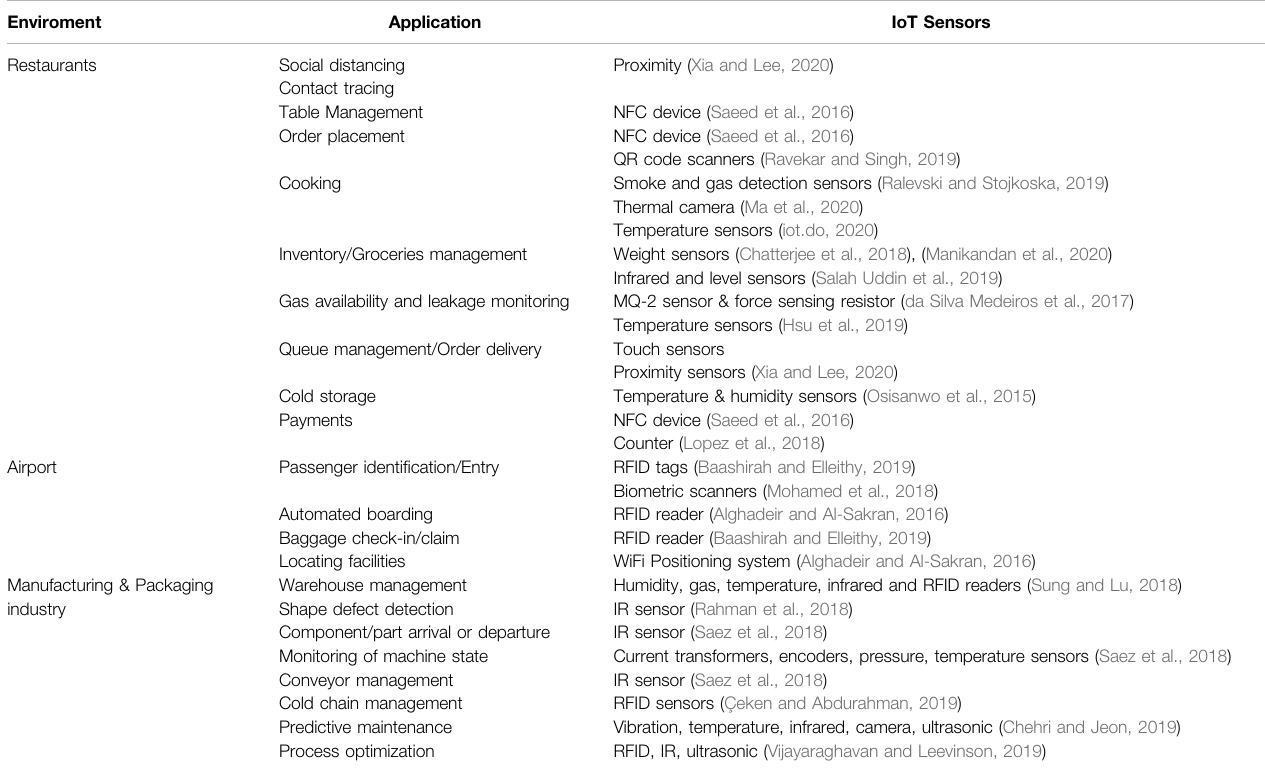
TABLE 1 | ( Continued ) IoT Sensors for COVID-19